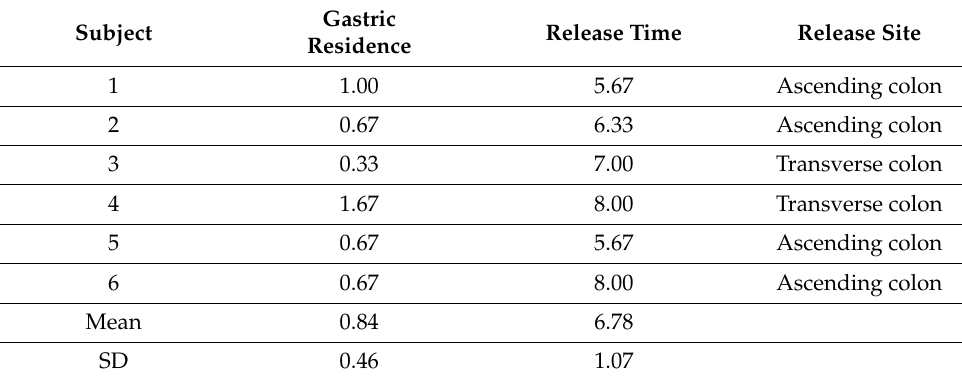
Table 3. Gastric residence (h), release time (h) and release site of labeled units in six fasted volunteers. Adapted from Ref. [49].